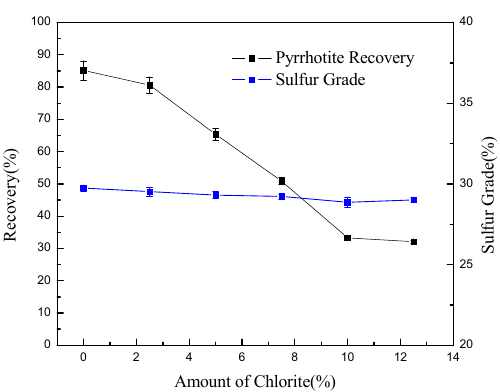
Figure 3. Effect of chlorite on the flotation recovery of pyrrhotite and grade of sulfide (pH = 9.0 ± 0.2; C(potassium amylxanthate) = 1 × 10 − 4 mol/L; C(methyl isobutyl carbinol (MIBC))= 1 × 10 − 4 mol/L).